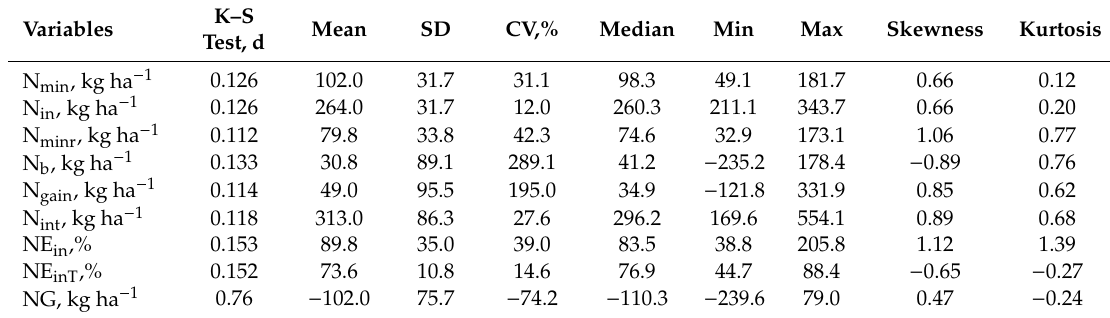
Table 4. Descriptive statistics of WOSR of soil characteristics and indicators of nitrogen management.